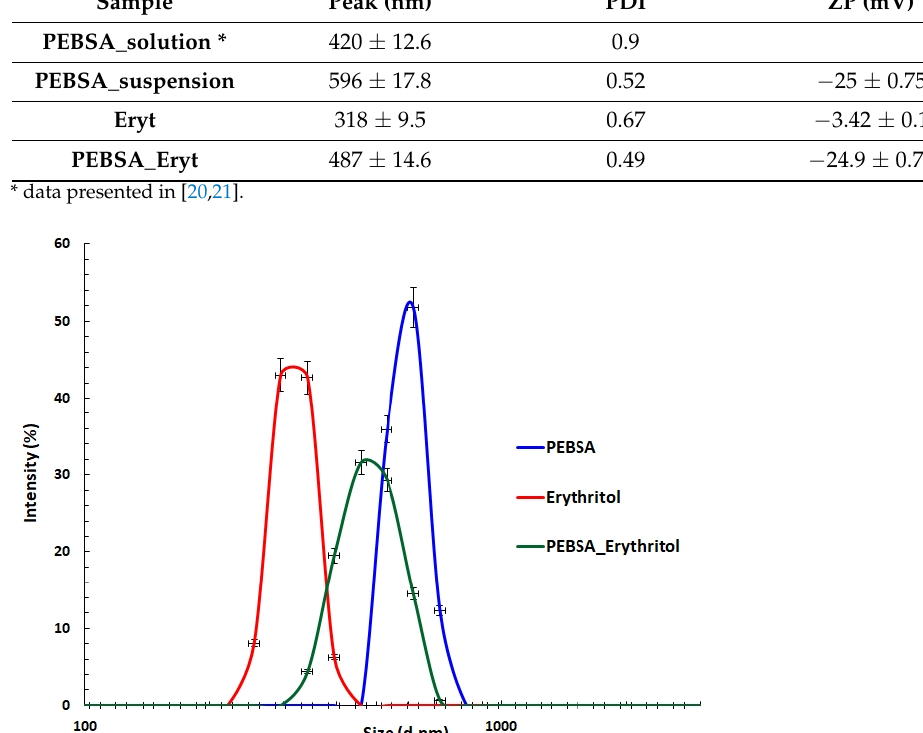
Figure 6. Size distribution of PEBSA_suspension, Eryt, and PEBSA_Eryt bioactive compound. Table 4. Peak mean diameters and PDI values measured by DLS.